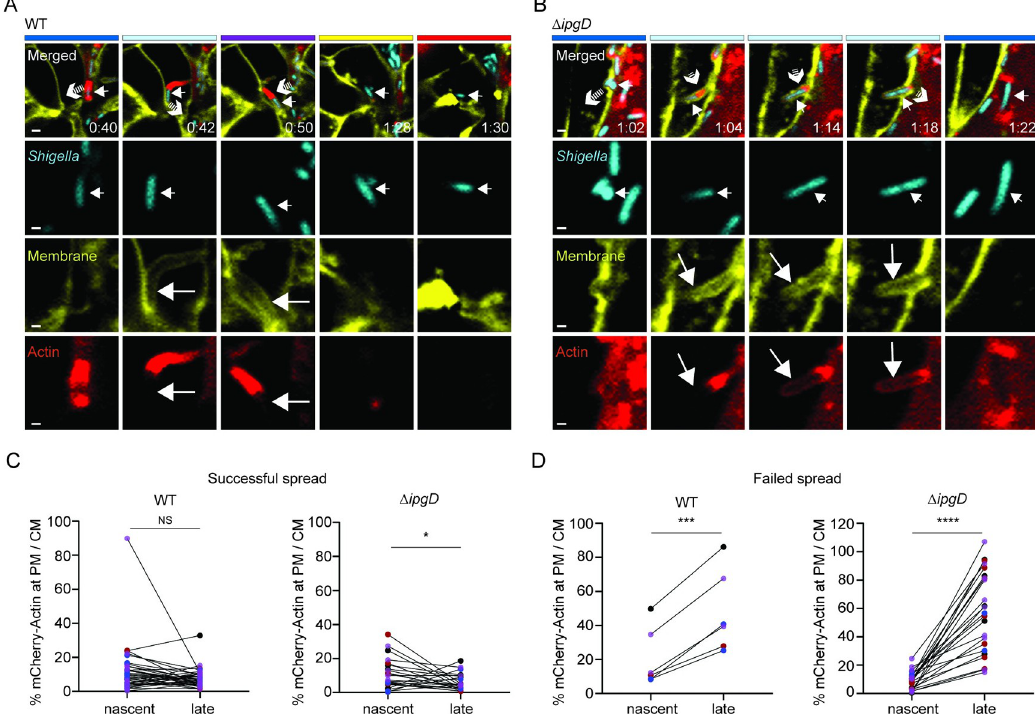
Fig 4. Dynamics of cortical actin levels in protrusion membrane during S . flexneri cell-to-cell spread. (A) Representative images for successful dissemination. WT S . flexneri pCFP (blue, small white arrow, merged panel) forming a membrane protrusion (t[0:42]; large white arrow pointing to plasma membrane, yellow) exhibiting very low/undetectable cortical actin (large white arrow, mCherry-Actin, red) that successfully resolves into a DMV (t[1:28]) from which the bacterium escapes (t[1:30]; small white arrow, merged panel). (B) Representative images for failed dissemination. Δ ipgD S . flexneri pCFP (blue, small white arrow, merged panel) forming a membrane protrusion (t[1:04]; large white arrow pointing to plasma membrane, yellow) that starts displaying cortical actin at later time point (t[1:14]; large white arrow, mCherry-Actin, red), fails to resolve into a DMV and collapses back to the primarily infected cell (t[1:22]; small white arrow, merged panel). Color-coded bars on top indicate the compartments occupied by the bacteria. t, relative time, hour: minute; scale bar, 2 μ m for merged panel, 1 μ m for single color. White arrows with striped tails in Merged panel images indicate the direction of bacterial movement and predict S . flexneri location in the next frame. (C-D) Graphs showing how mCherry-Actin probe levels change between nascent protrusion membrane and late protrusion membrane during successful (C) and failed (D) S . flexneri pCFP (WT and Δ ipgD ) spread; mCherry-Actin levels (%) at protrusion membrane (PM) normalized with mCherry-Actin levels at cell membrane (CM) as described in Fig 3. Circles represent data points and colors indicate replicate groups; 47 mCherry-Actin measurements, WT pCFP and Δ ipgD pCFP protrusions (nascent, late); ( n = 4). Statistics: paired t test analysis; ���� P < 0.0001, ��� P < 0.001, � P < 0.05; NS, not significant.